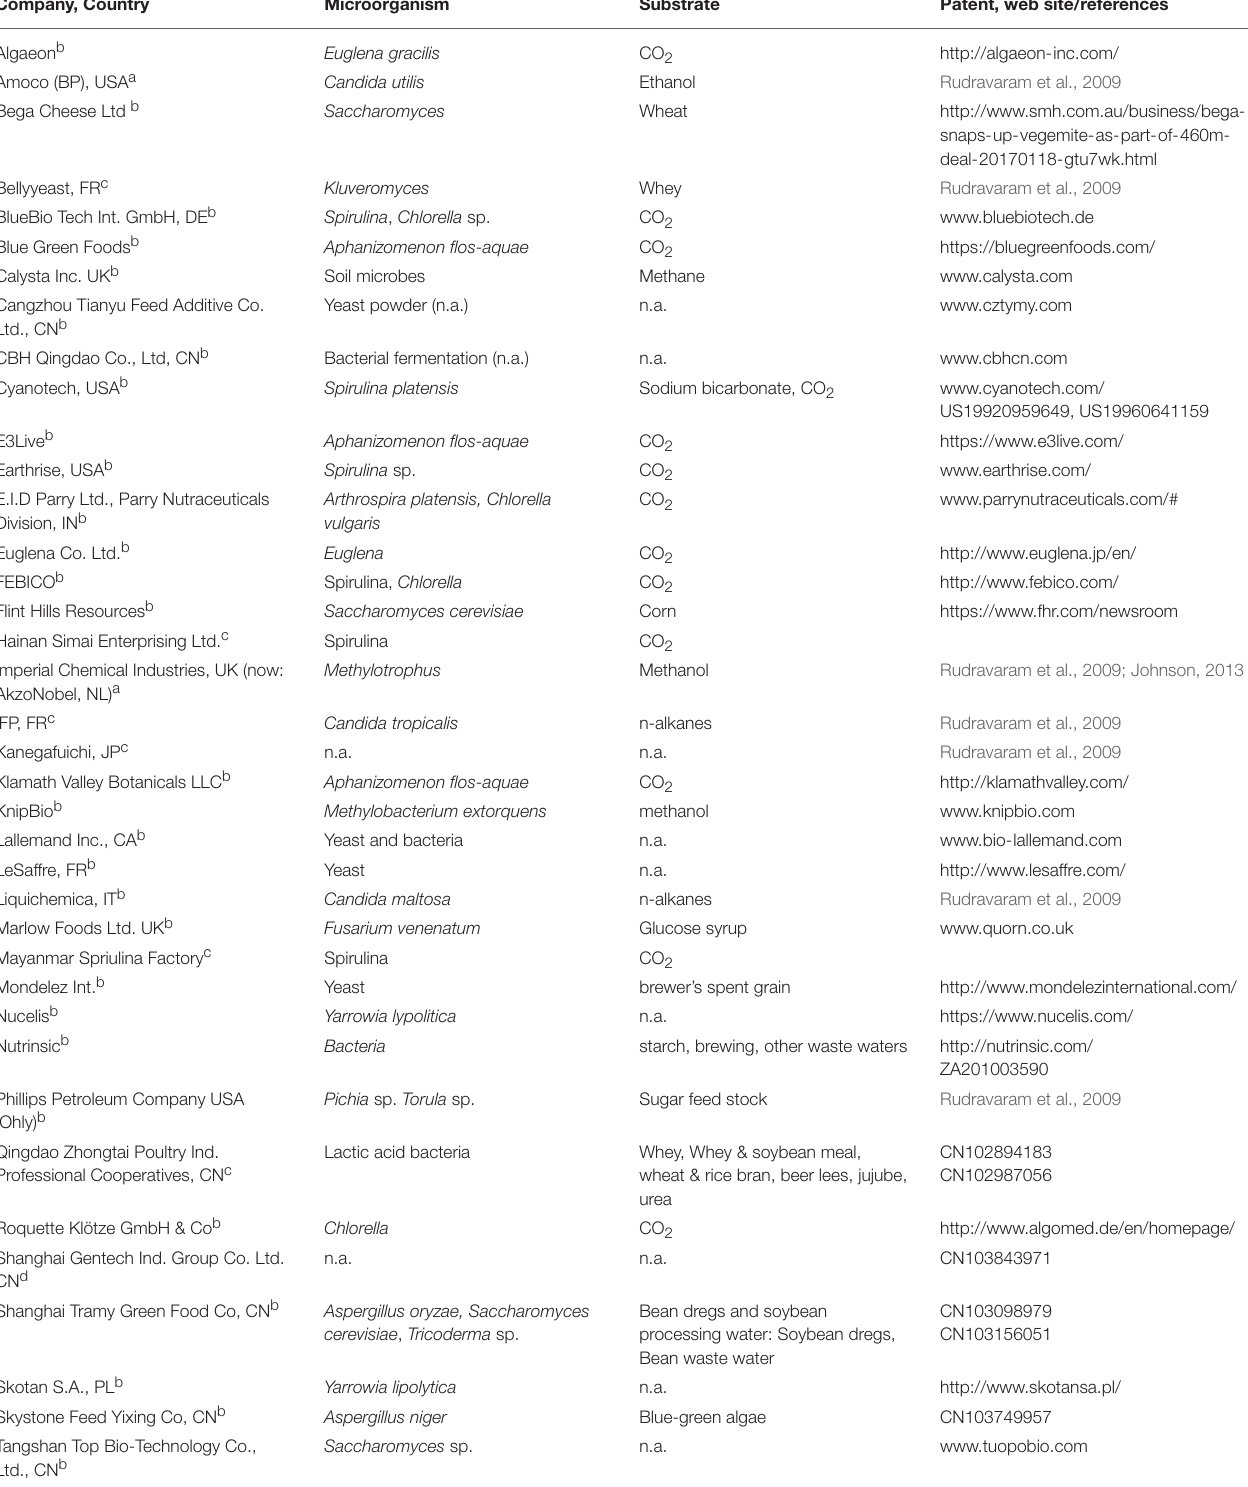
TABLE 4 | Industrial establishments involved in SCP